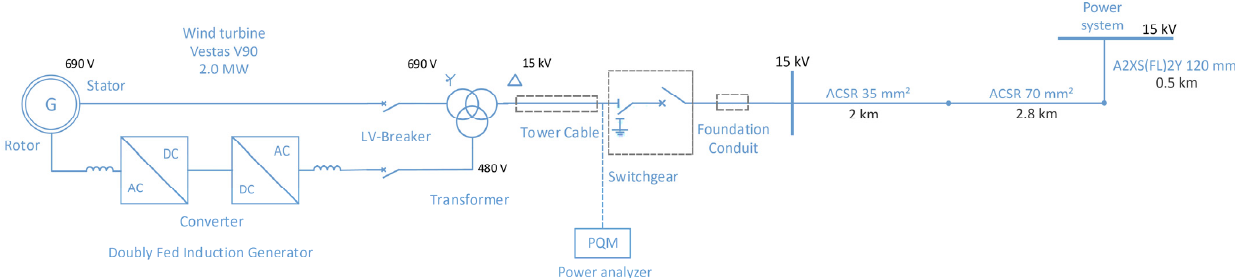
Figure 3. Schematic diagram of a fragment of the power grid with the measurement location marked.